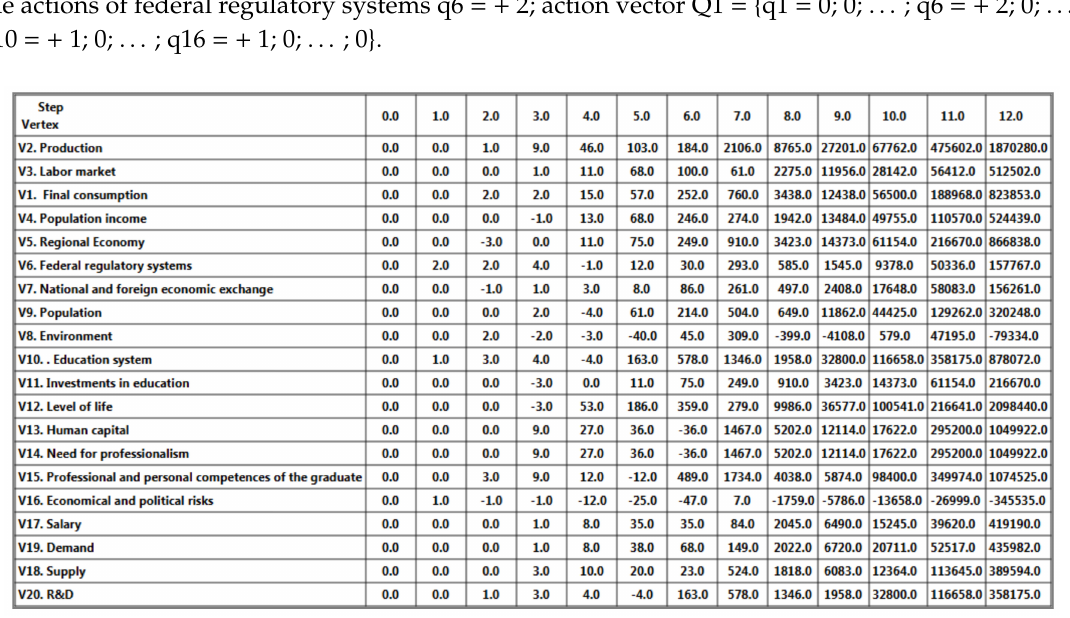
Figure 13. Scenario "Improving the conditions of higher education and economical and political risks increasing, while federal regulatory system actions are taken" disturbing momentum q6 = + 2, q10 = + 1 and q16 = + 1 (fragment from the computer data processing results on the program